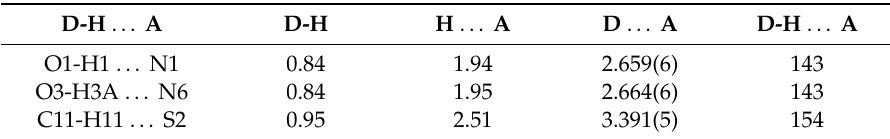
Table 3. Hydrogen bond parameters for 6